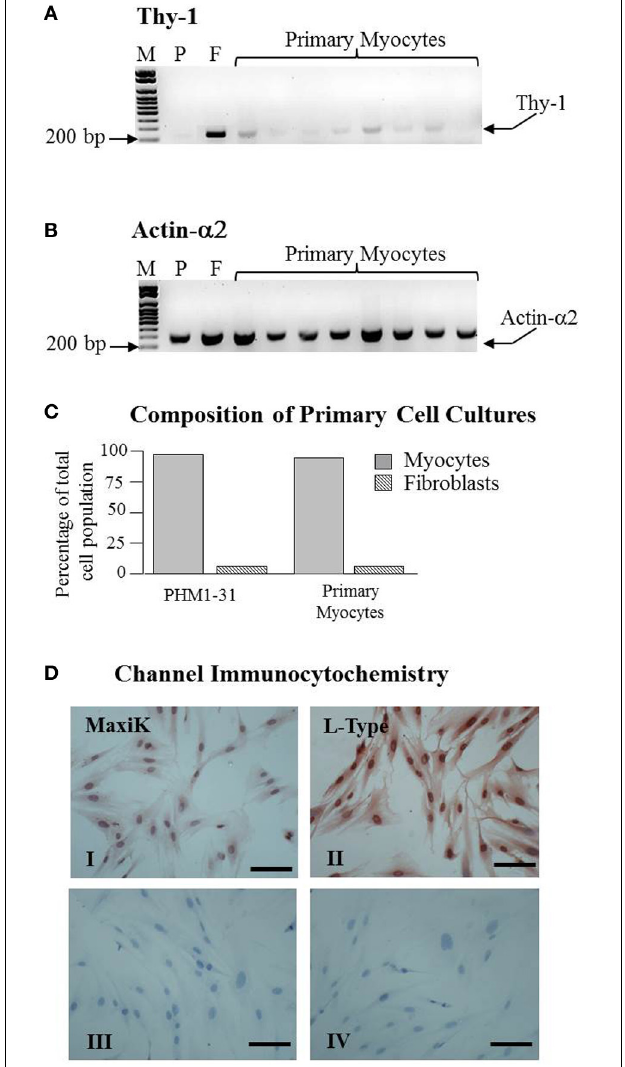
FIGURE 1 | Primary myometrial cell cultures are composed primarily of myocytes and express both the MaxiK and L-type Ca 2 + channels. RNA from primary myometrial cell cultures was extracted and amplified by PCR. (A) Primary myometrial cell cultures express a low level of Thy-1 mRNA indicating a low level of Fibroblasts in the culture. (B) Primary myometrial cell cultures express a high level of Actin- α 2 mRNA indicating a high level of myocytes in the culture. Manual quantification of the relative band intensities was used to confirm the presence of myocytes and to estimate the level of fibroblast contamination. (C) Primary myometrial cell cultures are comprised of 88–98% myocytes (gray bar) and between 1.2 and 11% fibroblasts (striped bar) which is comparable to the PHM1 cultures. (D) Myometrial cells were staining using antibodies specific to MaxiK (I) and L-Type (II) channels. Controls excluded primary (III) and secondary antibody (IV). Dark red/brown staining denotes specific staining of the protein of interest (scale bar is 100 μ